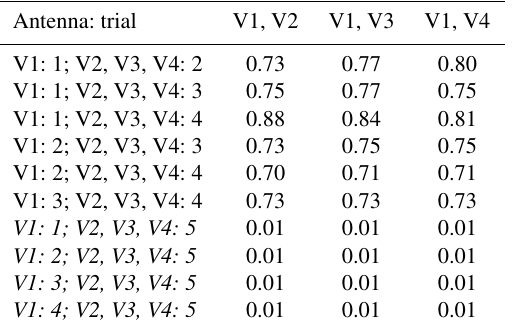
Table 7. Mean values of the power correlation coefficients over frequency for different antenna pairs. The first column indicates from which measurement trial the measured sample sequences of the specified antenna